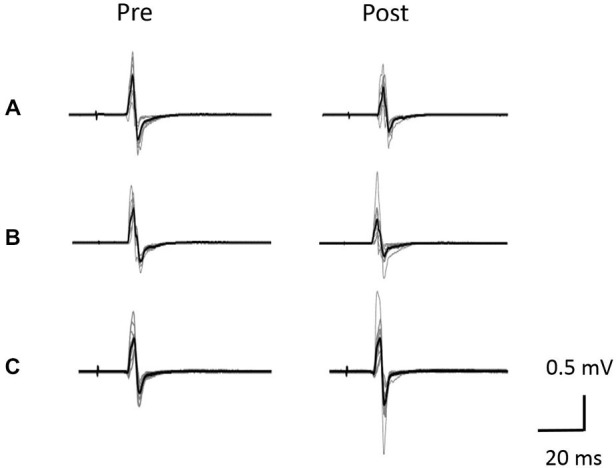
Typical motor-evoked potential (MEP) waveforms from a representative individual. (A) VC task. (B) Tetanic ES task. (C) The 90% MT ES task.Representative superimposed MEP waveforms elicited at the three interventions. MEPs of the right abductor pollicis brevis (APB) were evoked by transcranial magnetic stimulation (TMS) at pre and post-intervention for three interventions. Gray bars indicate the raw waveform. Black bars indicate the mean MEP waveforms.